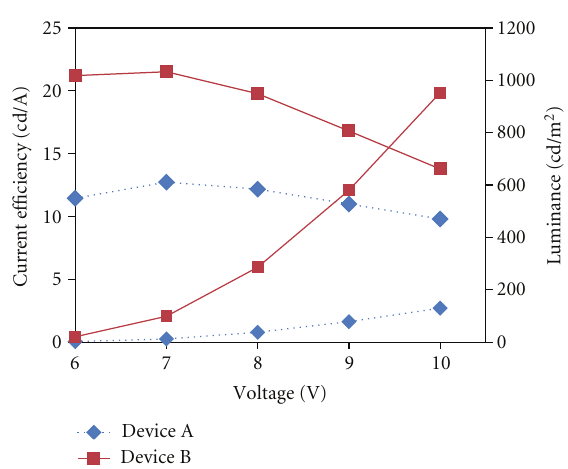
Figure 4: Current e ffi ciency-voltage-luminance characteristics of the devices (A,